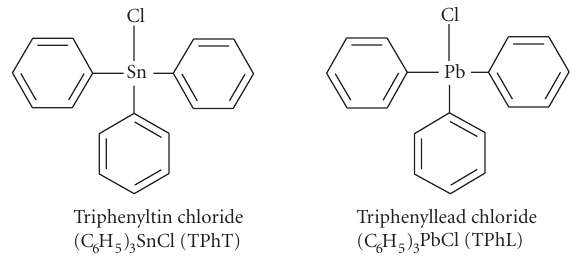
Figure 1: The chemical structure of the TPhT and TPhL